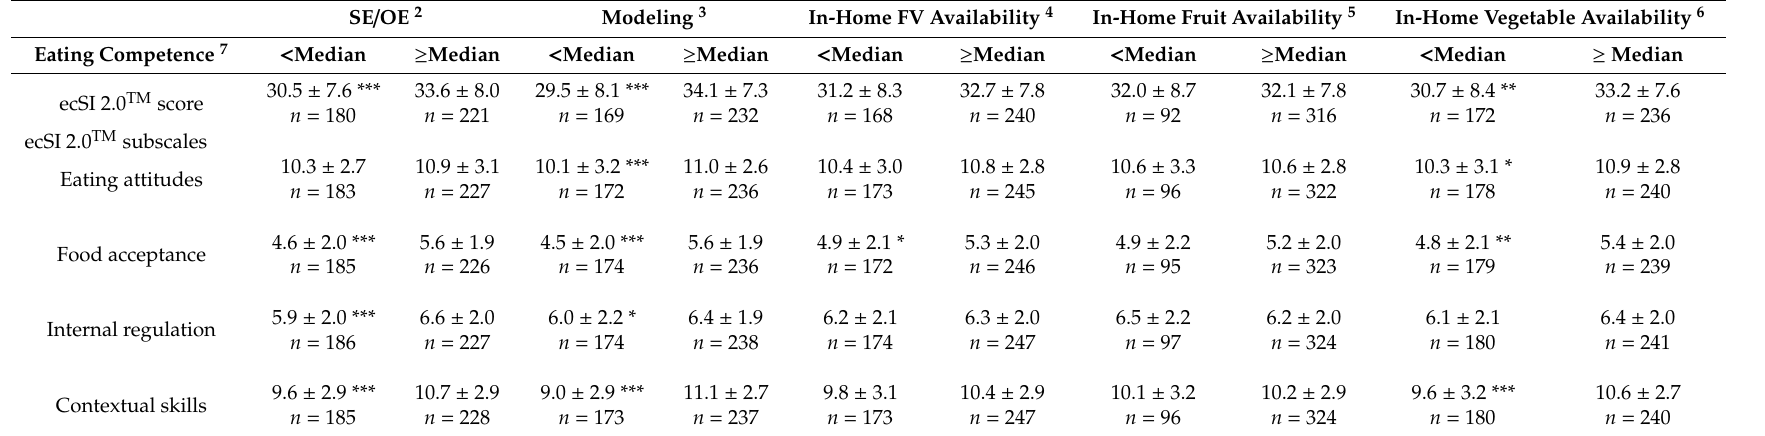
Table 3. ecSI 2.0 TM scores compared between parents below and at / above median survey scores 1